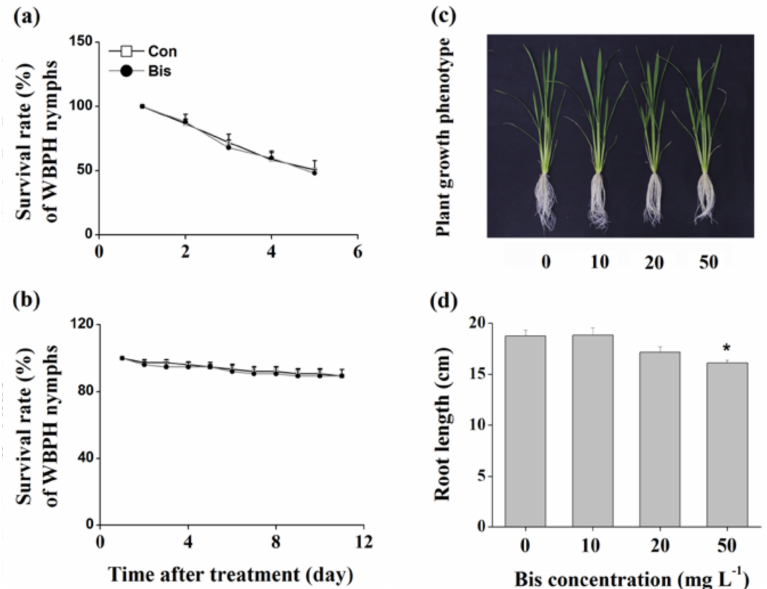
Figure 3. Bismerthiazol has no direct toxicity to WBPH but does slightly impair plant growth. ( a ) Mean survival rates (+SE, n = 6) of 15 newly hatched WBPH nymphs fed on artificial diets with 50 mg L − 1 of bismerthiazol (Bis) or without bismerthiazol (Con); ( b ) Mean survival rates (+SE, n = 6) of 15 newly hatched WBPH nymphs that were exposed to 50 mg L − 1 of bismerthiazol (Bis) or to buffer only (Con); ( c ) Growth phenotypes of plants grown in nutrient solutions with different concentrations of bismerthiazol for 10 days; ( d ) Mean root lengths (+ SE, n = 6) of plants grown in nutrient solutions with different concentrations of bismerthiazol for 10 days. Asterisks indicate significant differences between treatments and controls (* p < 0.05; Student’s t